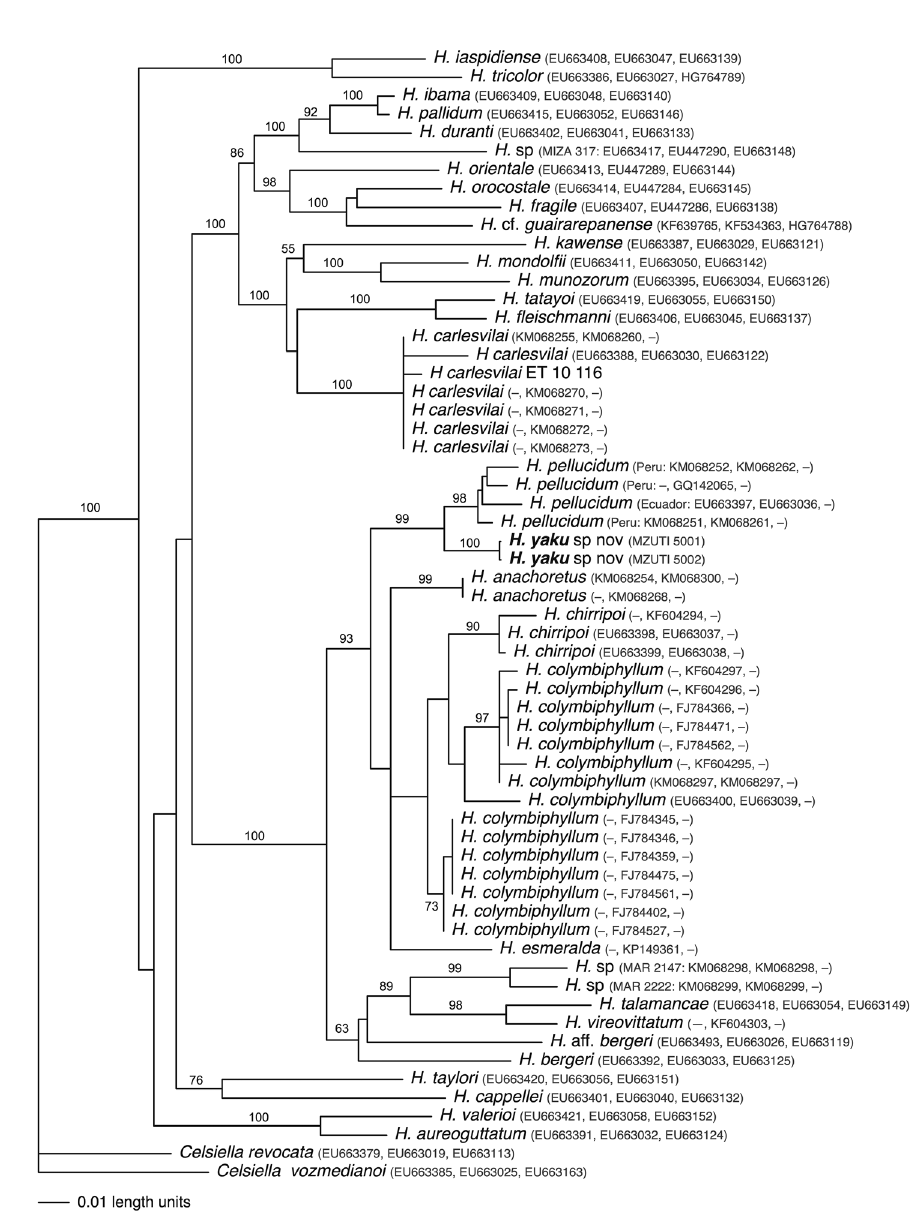
Figure 2. Phylogenetic relationships of Hyalinobatrachium inferred from combined mitochondrial genes (12S, 16S, ND1) under ML criterion. All sequences were downloaded from GenBank, except for those of the new species (Genbank codes: MF002063–MF002068). Genbank codes cited next to species names are in the following order: 12S, 16S, ND1. Associated locality data is available at Genbank, as well as in Guayasamin et al. (2008), Castroviejo-Fisher et al. (2014), and Twomey et al.